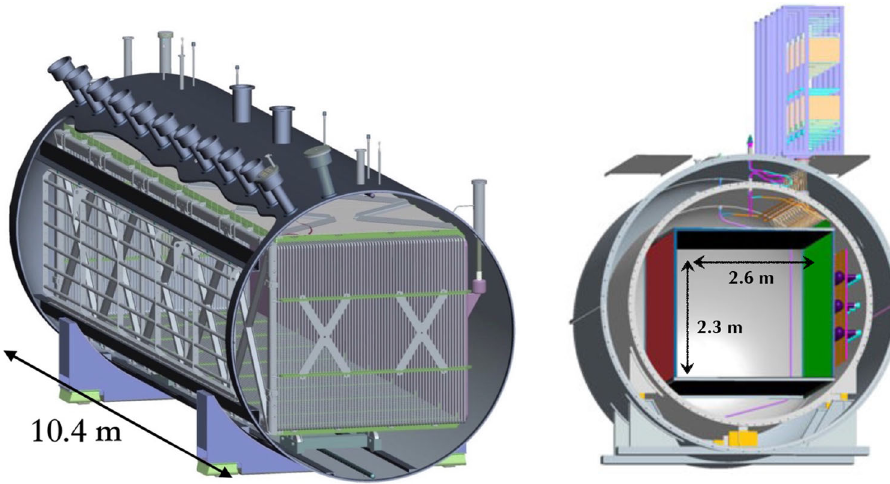
Fig. 1 A schematic view of the MicroBooNE detector. The three wire planes, shown on the right side of the cylindrical cryostat in the right-hand image, contain vertical wires and wires ± 60 ◦ to the vertical. The wire planes are the